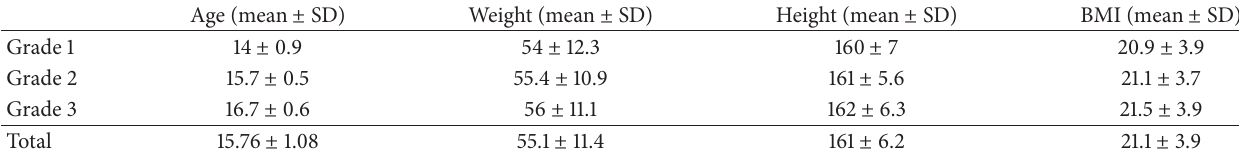
Table 2: Mean age, weight, height, and BMI of high school girls in Ilam.